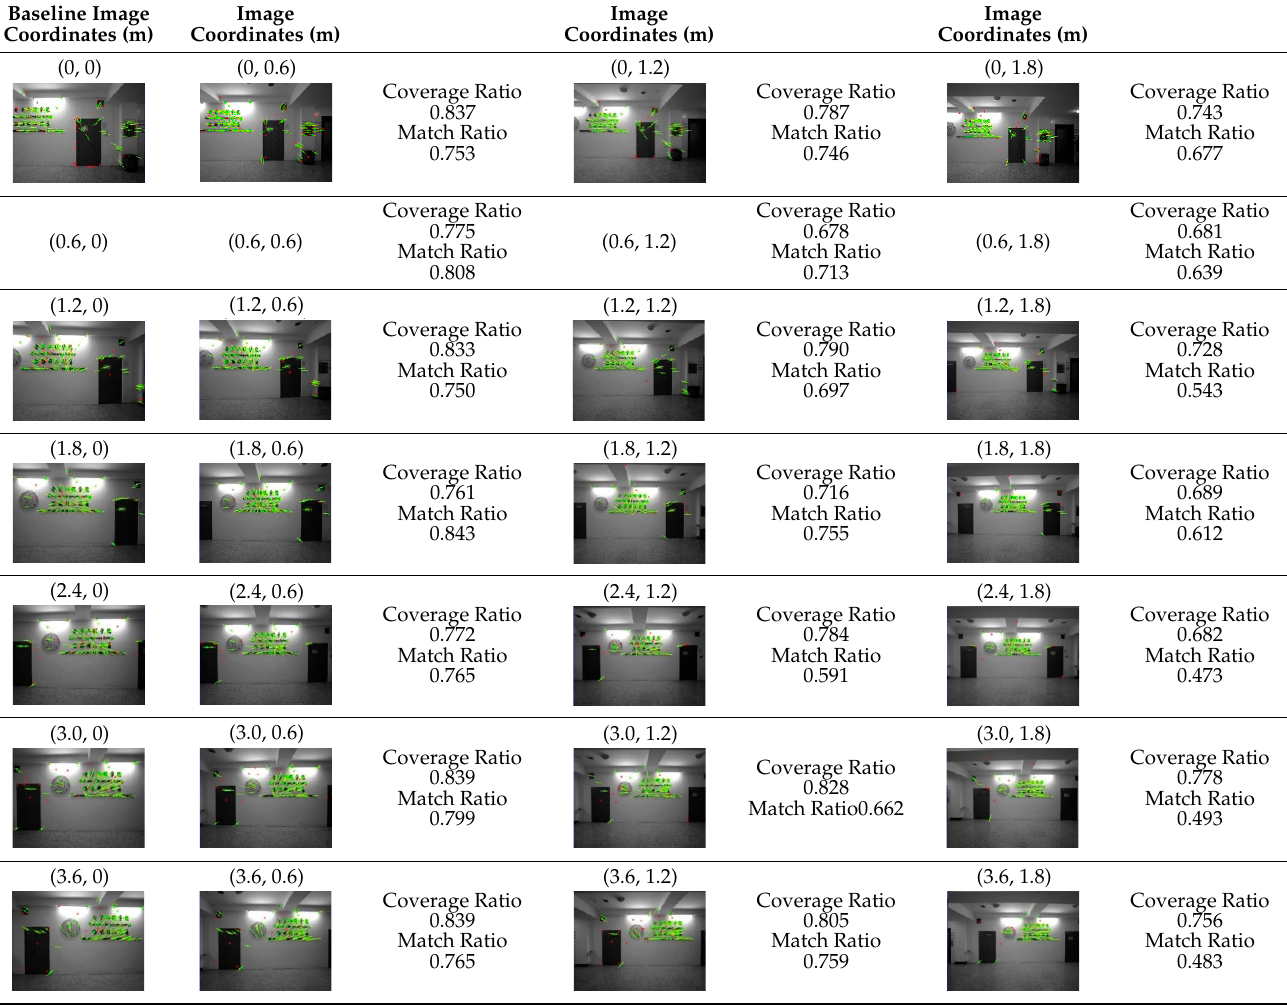
Table 1. Epipole distribution of the images collected at each coordinate point.